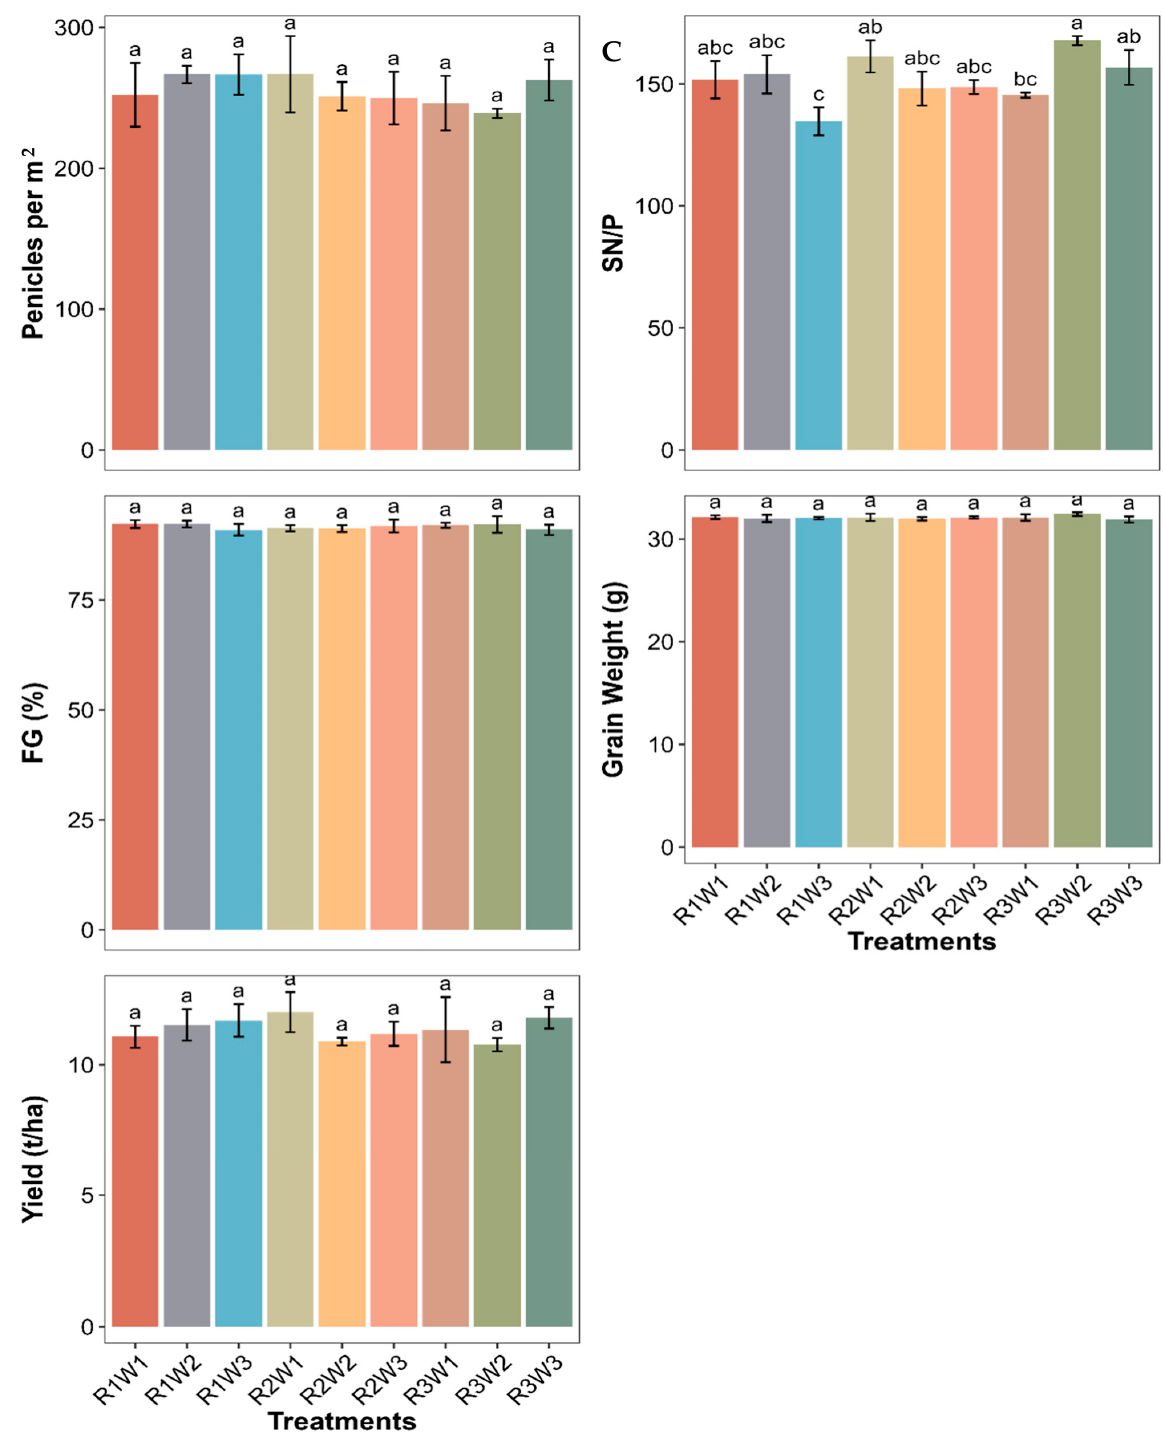
Figure 3. Yield and related attributes under different N rates during rice season in 2016 ( A ), 2017 ( B ), and 2018 ( C ). SN/P and FG (%) represent the spikelet number per panicle and grain filling percentage, respectively. R1 = 300 kg N ha − 1 , R2 = 240 kg N ha − 1 , R3 = 180 kg N ha − 1 represent the rice fertilizer rates and W1 = 225 kg N ha − 1 , W2 = 180 kg N ha − 1 , W3 = 135 kg N ha − 1 represent the wheat fertilizer rates. Vertical bars represent the S.E of the means (n = 3). Mean bars among treatments marked by the same letters are not significantly different at p < 0.05.